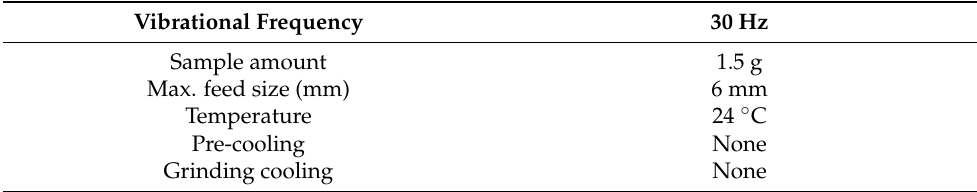
Table 1. Ball-milling treatment conditions.